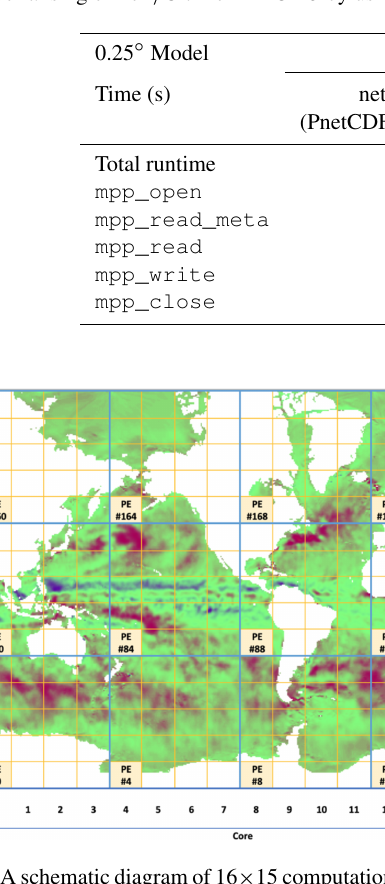
Table 4. Serial single-file I / O time in MOM5 by using 240 and 960 PEs.